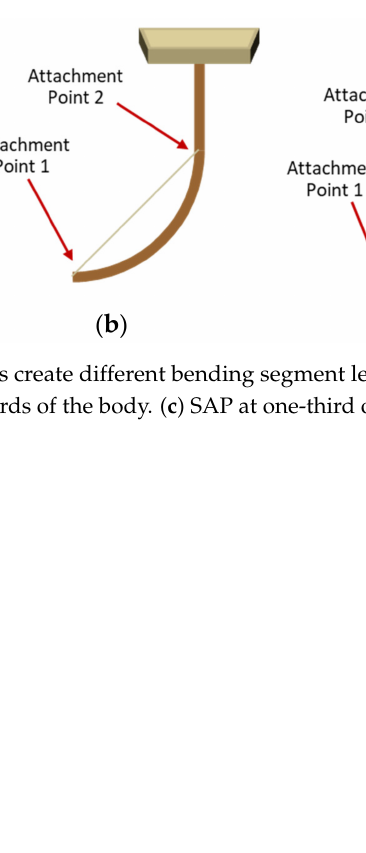
Figure 3. Adding a rotary actuator at the manipulator’s base results in a volumetric